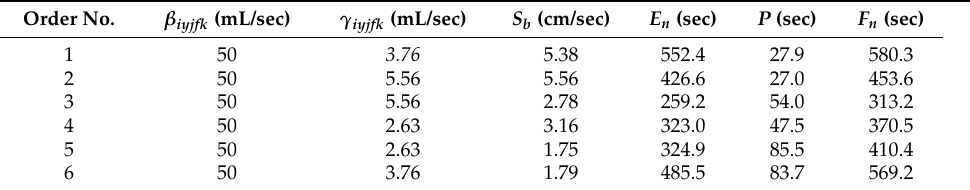
Table 2. Optimal